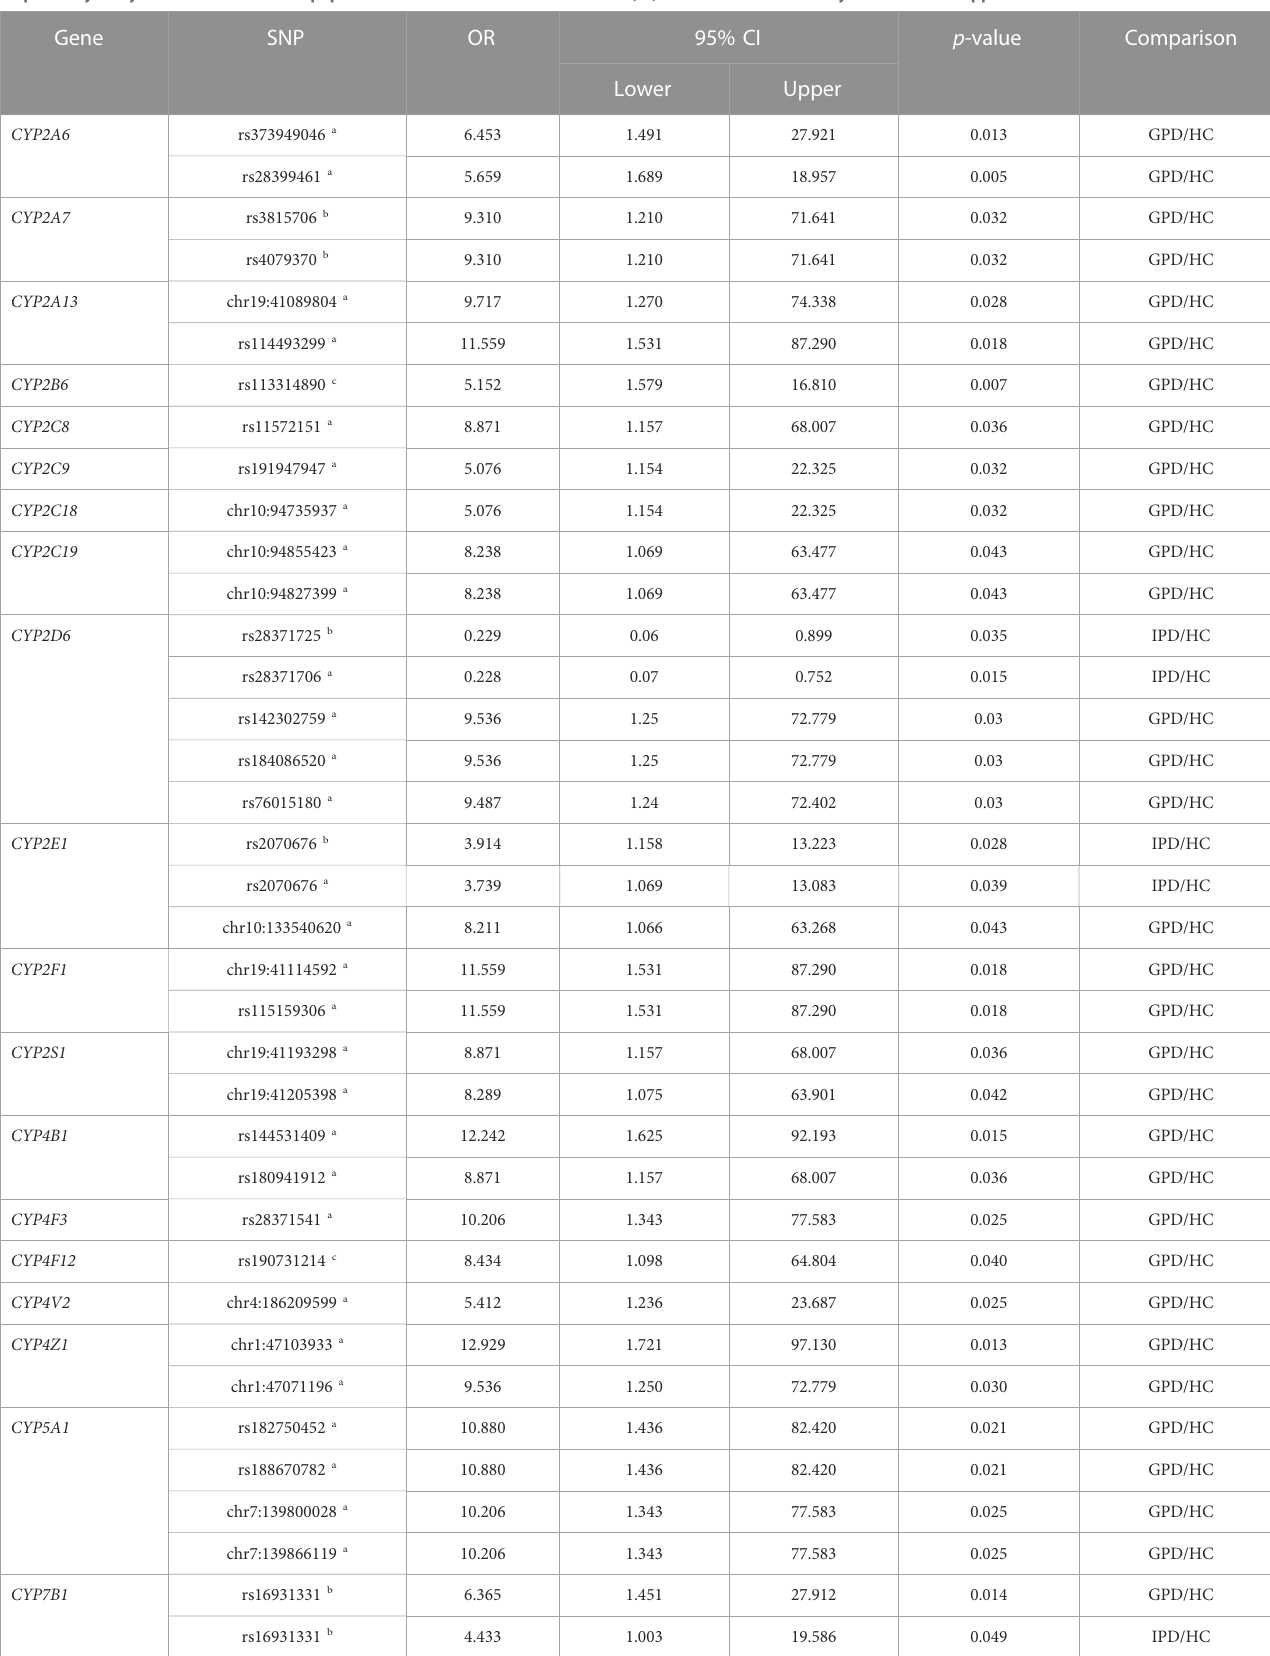
TABLE 3 Summary of selected single nucleotide polymorphisms (SNP) with statistically signi fi cant association ( p -value < 0.05) to Parkinson´s Disease (PD) for various P450s. The strength of association is represented by the odds ratio (OR) for patients with genetic PD (GPD) or idiopathic PD (IPD) and the healthy control group (HC),